Question: Express in one sentence what the figure is showing.
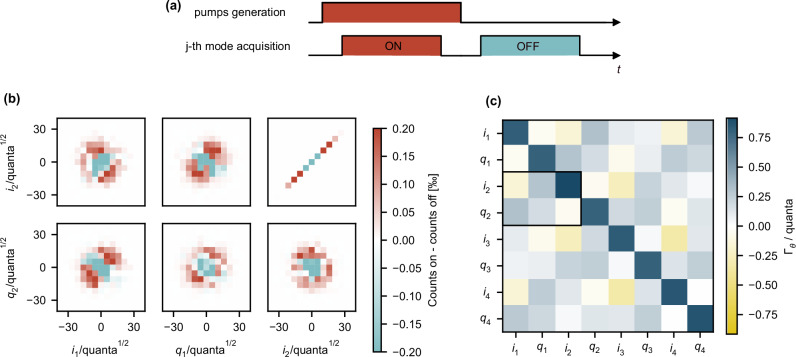
Answer: Gaussian cluster state covariance matrix reconstruction. a Scheme of the pumps interleaved generation via an ON-OFF protocol, which guarantees referenced-state multiplexed heterodyne detection of modes. b Histograms reporting the counts of quadratures measured in the ON condition, subtracted using the reference state acquired during the OFF state for modes 1 and 2. Correlations are reported in the pairs ( i 2 , q 1 ) and ( q 2 , i 1 ), while anti-correlations are in ( i 2 , i 1 ). c Covariance matrix in the yet unknown θ -rotated basis Γ θ reconstructed from multiplexed heterodyne measurements on 4 modes cyclically clustered via 4 pumps at P p = −24 dBm. The black box indicates the elements of the covariance matrix corresponding to the data reported in ( b ).